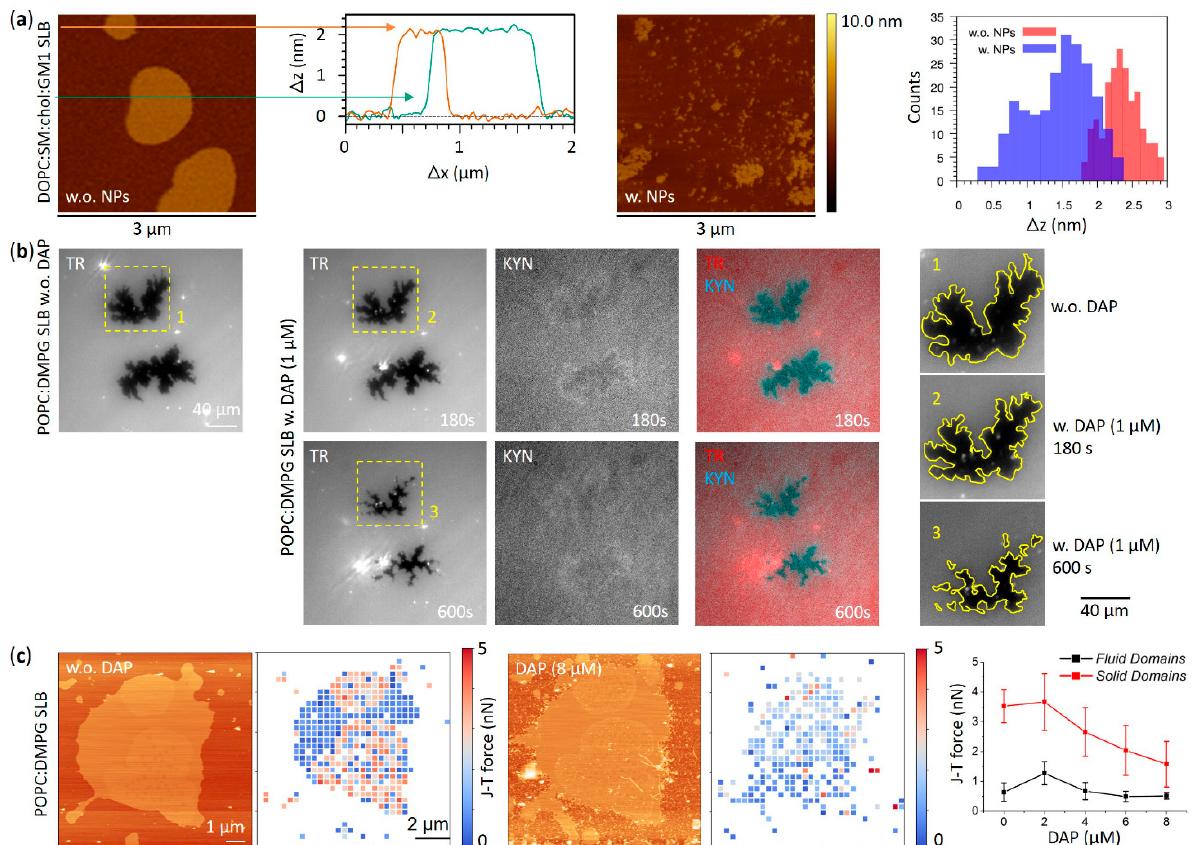
Figure 3. Perturbation of membrane ordered–disordered phase separation upon interaction with amphiphilic AuNPs and amphiphilic peptides. ( a ) Topographic AFM images showing fragmentation of ordered domains induced by ~3 nm MUS:OT AuNPs on phase-separated lipid bilayers containing DOPC:SM:chol:GM1 (63:31:1:5 molar ratio). Two height profiles of the phase-separated membrane without NPs are also reported. On the right: comparison of height difference distributions ( ∆ z) between ordered and disordered domains before and after NP/membrane interaction. ( b ) Fluorescence images of the same region of a POPC:1,2-dimyristoyl-sn-glycero-3-PG (DMPG) 1:1 phase-separated SLB with PG-enriched ordered domains recorded before and after exposure to the lipopetide DAP (1 µ M). Two solid ordered domains (dark regions) in a liquid disordered background (bright region) containing the fluorescence lipid probe DHPE-Texas Red (TR, 1%) are shown. The channel of kynurenine (KYN)—an intrinsically fluorescent DAP residue—is used to visualize the morphology of ordered domains since DAP strongly interacts with PG lipids. Overall, the SLB/DAP interaction induces an extensive size reduction of the solid domains equal to 59%. ( c ) Force spectroscopy analysis and topographic AFM images of the same POPC:DMPG 1:1 SLB before and after exposure to increasing DAP concentrations (0–8 μ M). Jump-through (J–T) force maps (resolution 32 × 32 pixels) are reported next to each AFM image, together with the comparison of solid and fluid domains jump-through force upon increasing concentrations of DAP. ( a ) contains images by Canepa et al. [44] reprinted with minor modifications under a CC BY-NC 3.0 license with permission from the Royal Society of Chemistry. ( b , c ) are reproduced and adapted with